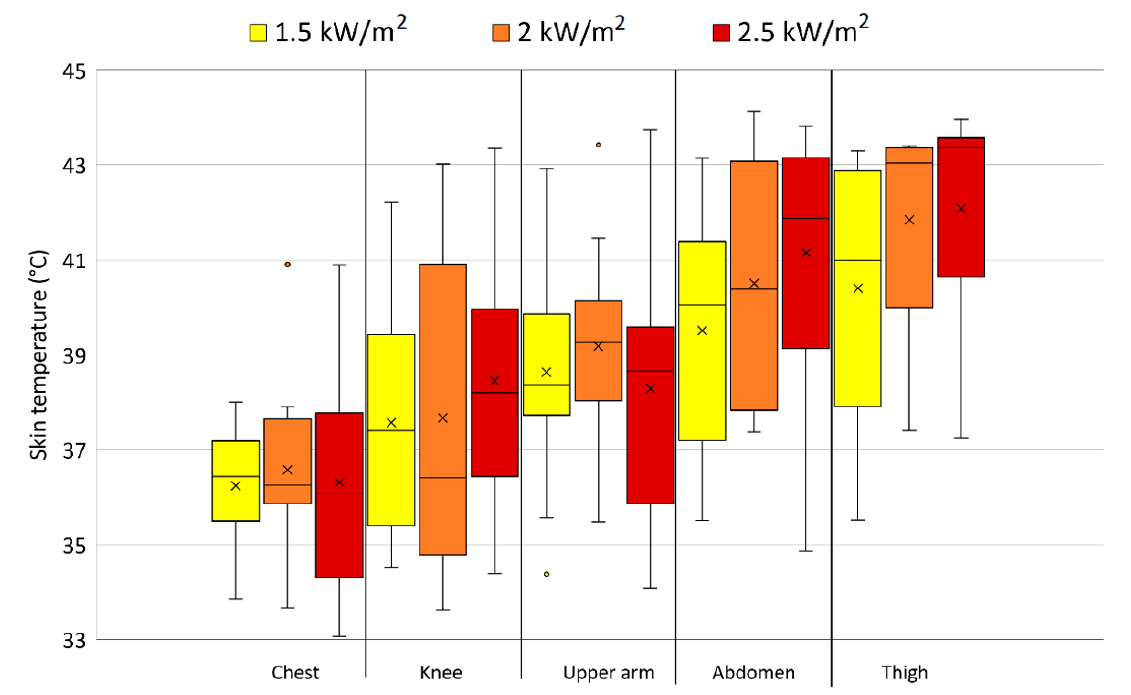
Figure 6. The median (horizontal line) and mean ( × ) highest measured skin temperatures with the standard deviations and the outliers ( ◦ ) at the various body locations across the test persons at the different radiation intensities.